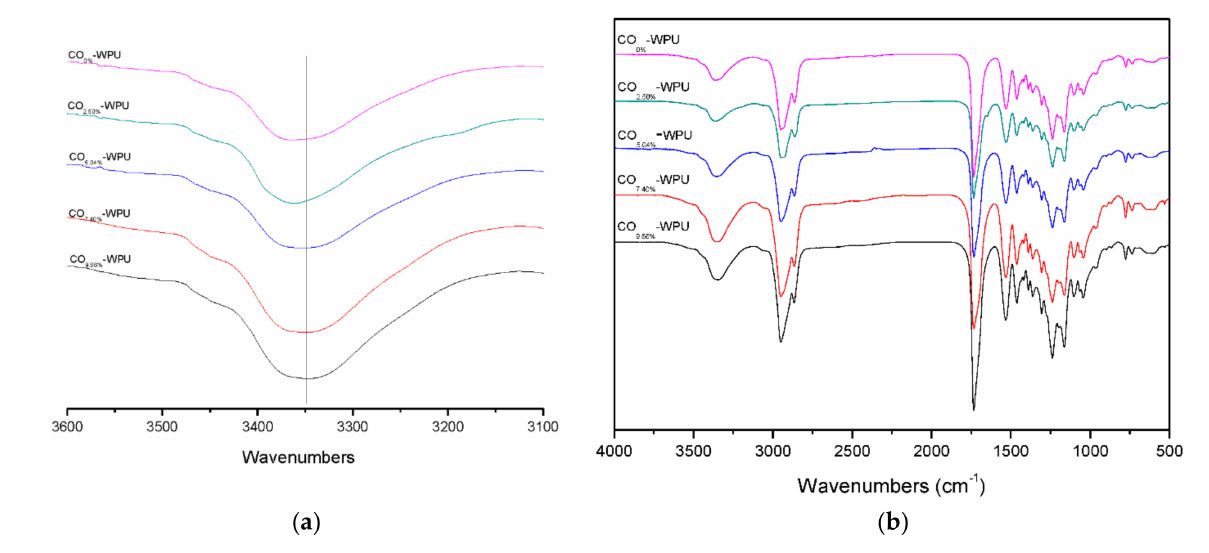
Figure 1. FT-IR spectra of WPUs. ( a ) in the wavenumber range of 3100–3600 cm − 1 ; ( b ) in the wavenumber range of 500–4000 cm − 1